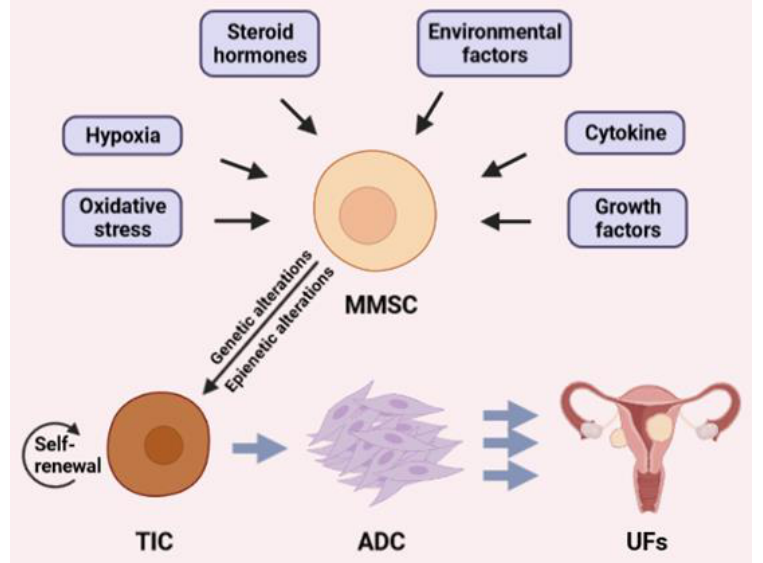
Figure 1. Several factors, including growth factors, oxidative stress, steroid hormones, hypoxia, en- vironmental insults, and cytokines, may trigger the conversion of MMSC to TIC leading to the for- mation of UFs. MMSC: myometrial stem cell, TIC: tumor-imitating cell, ADC: abnormally differen- tiated